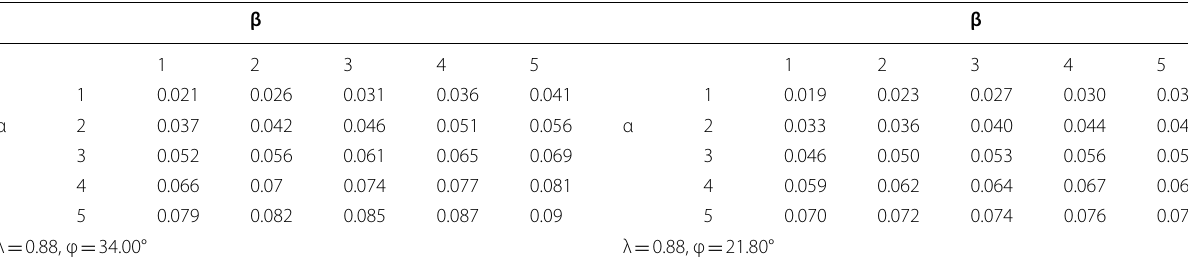
Table 1 Values of μ ’ obtained by varying α and β from 1° to 5° b